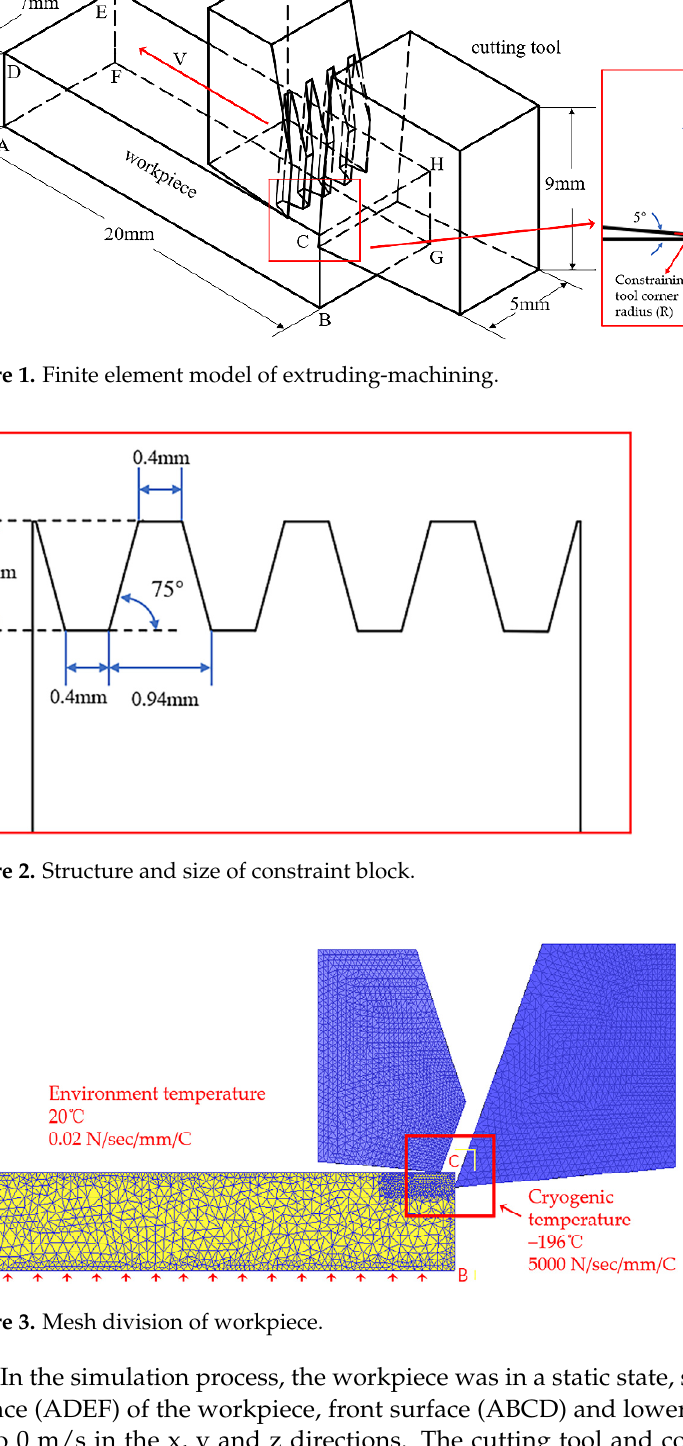
Figure 3. Mesh division of workpiece. Table 1. The thermodynamic material attribute parameters of pure copper and the tool.